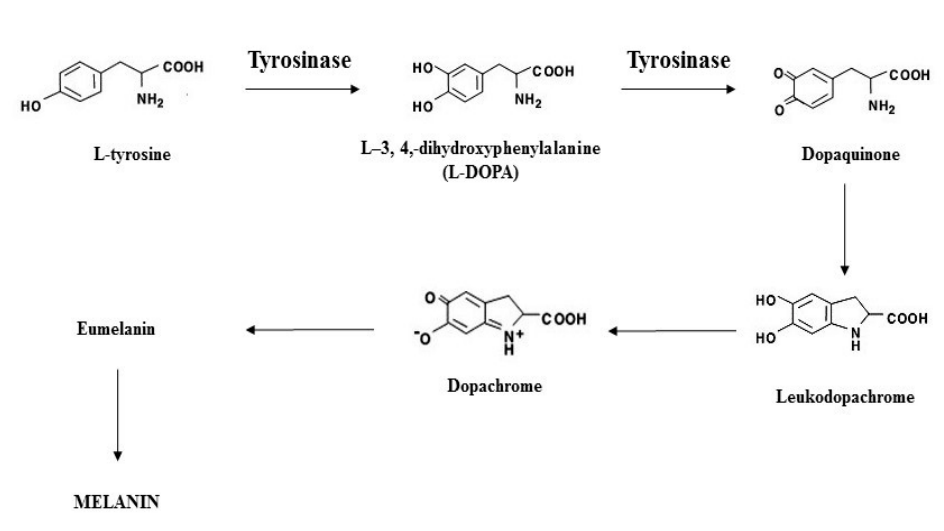
Scheme 1. Illustration of the melanogenesis pathway.